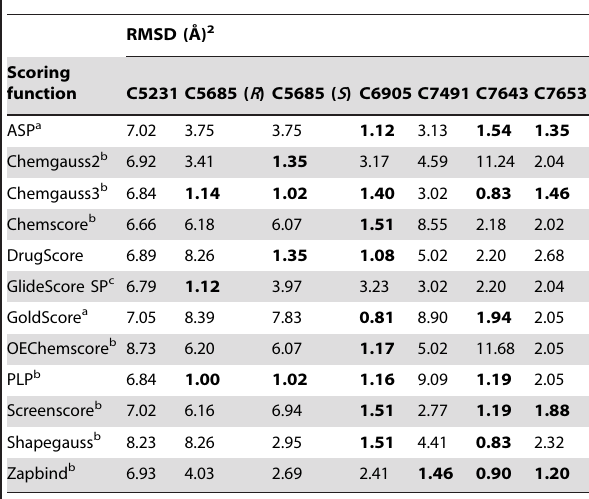
Table 6. RMSD values of the highest ranked docking poses after re-scoring of poses generated using the modified parameter settings in Glide. 1